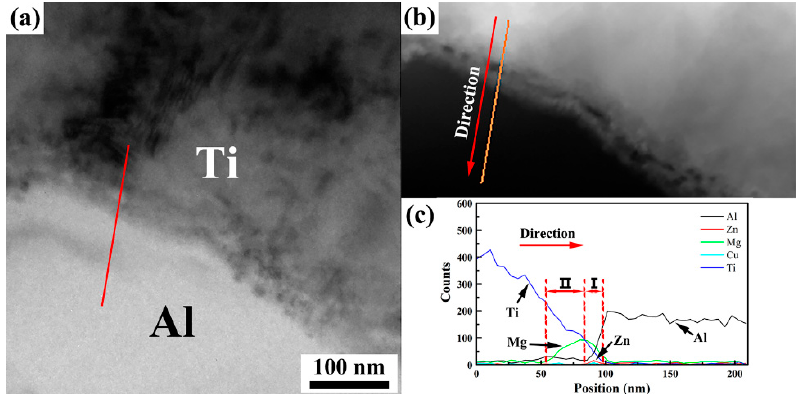
Figure 5. Energy spectrum analysis of the Ti–Al interface: ( a ) Bright-field TEM image of Ti–Al interface; ( b ) HAADF STEM image of Ti–Al interface and ( c ) line scan analysis of Ti–Al interface.